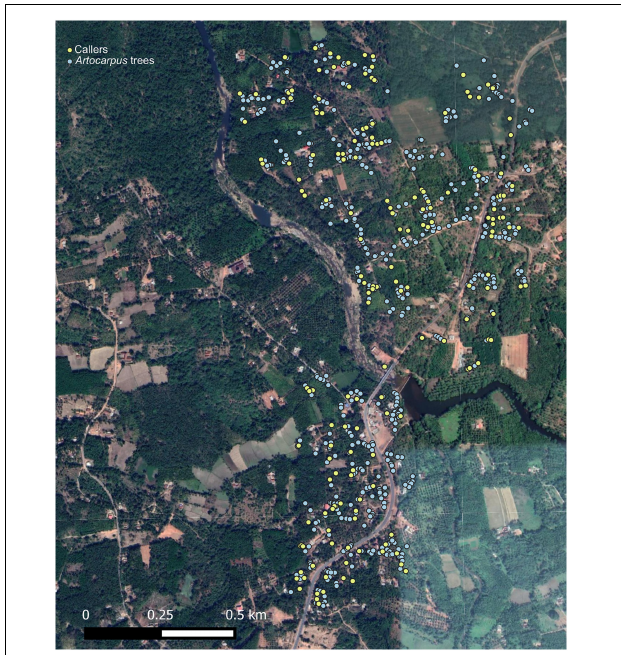
FIGURE 2 | Map of Artocarpus tree locations and calling male locations in the study area. 5148). The selection ratio (proportion used/proportion available) for Artocarpus spp. was found to be 39.7 and for non- Artocarpus spp. was found to be 0.06. This implies that the O. uninotatus males strongly prefer Artocarpus trees as calling sites. TABLE 1 | Nearest Neighbour analysis of spatial structure of calling males sampled on each